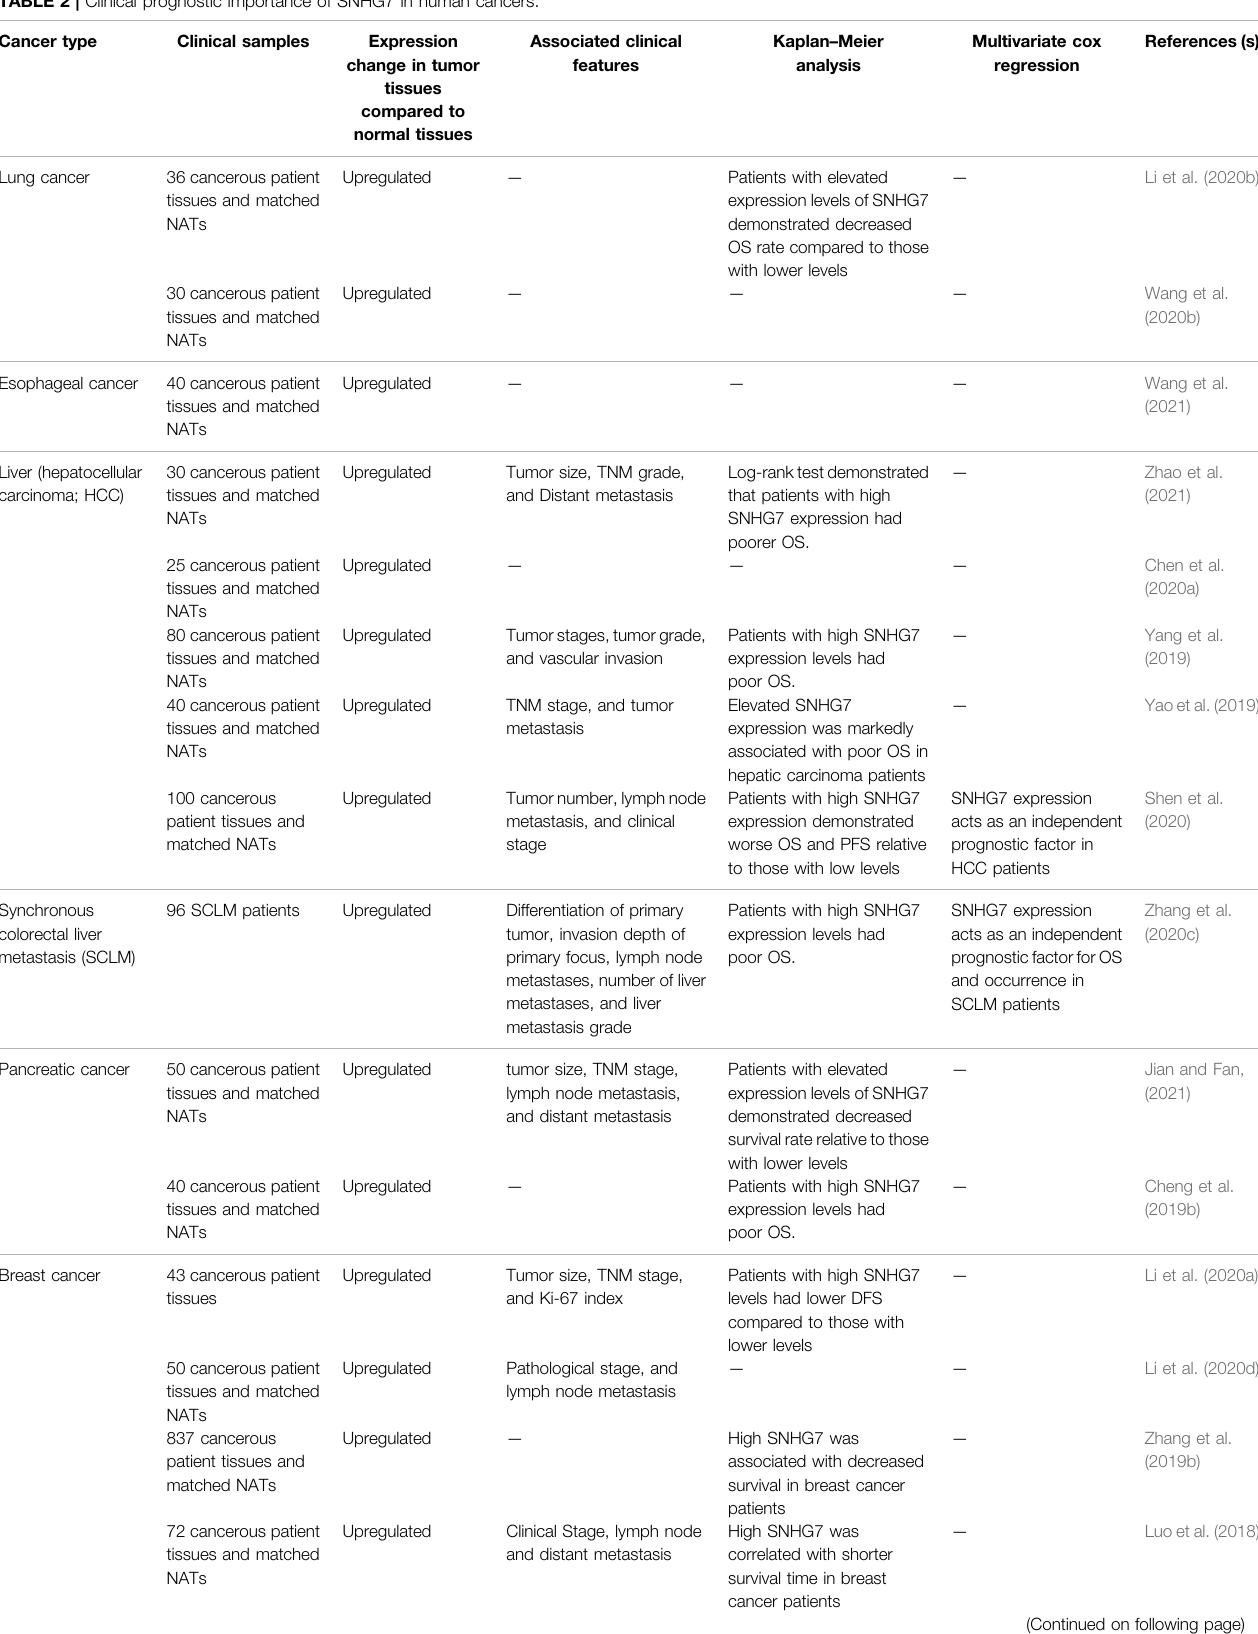
TABLE 2 | Clinical prognostic importance of SNHG7 in human